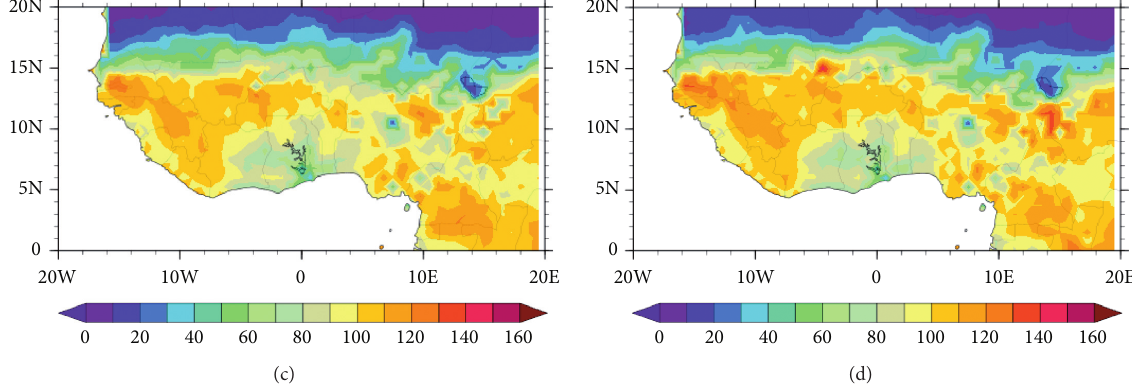
Figure 15: Spatial distribution of surface latent heat (w/m 2 ) for July 16 th –Sept 29 th , 2012. (a) Naoh. (b) CLM4. (c) NaohMP. (d) NoahMP GW.